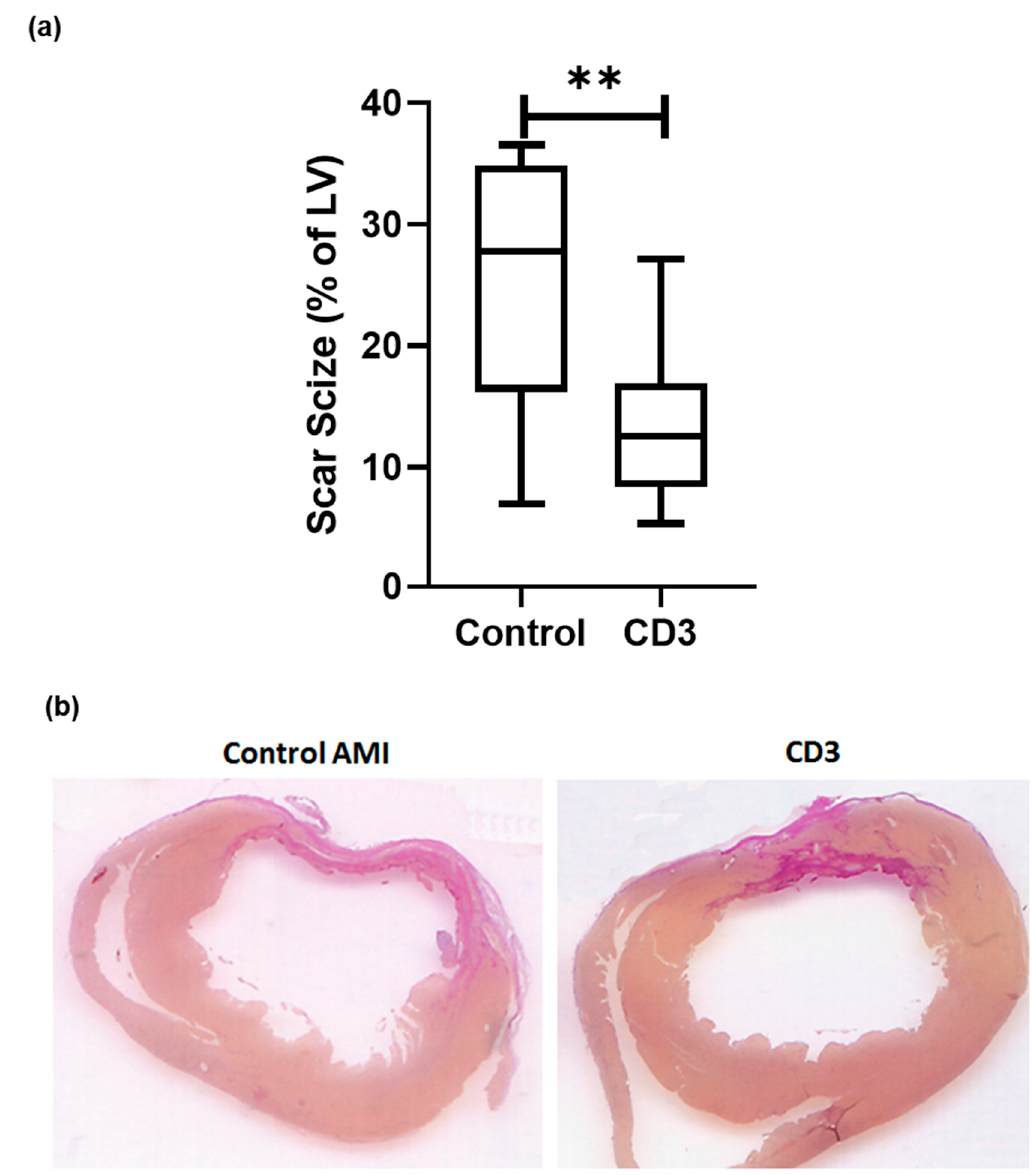
Figure 2. Rats were subjected to permanent left coronary artery (LCA) ligation. Rats were sacrificed 6 weeks after experimental infarction. Hearts were explanted and then sliced at three layers at the level of the largest extension of infarcted area and infarct sizes compared after staining with hematoxylin-eosin (H&E) and van Gieson (VG). ( a ) In animals treated with anti-CD-3 antibody (n = 13) left ventricular scar size was significantly reduced [12.6% (IQR 8.3–27.2) vs. 27.8% (IQR 16.2–34.9) p < 0.01] compared to vehicle treatment (n = 12). Representative ( b ) pictures are shown. ( p -values were expressed as follows: ** p < 0.01).